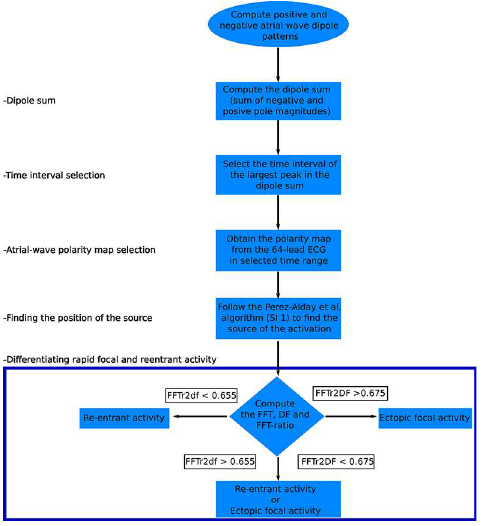
Fig 6. Schematic illustration of the algorithm to identify the location of atrial focal origin or re-entry from atrial wave polarity